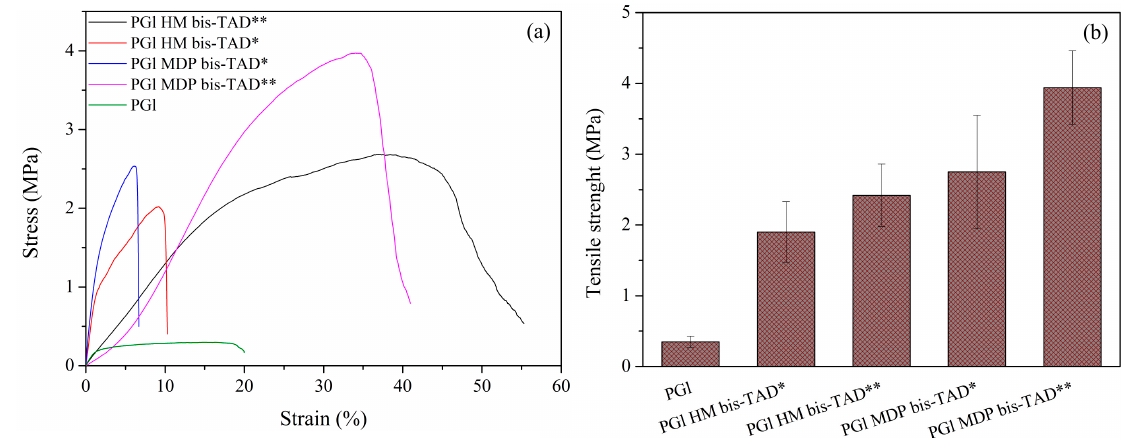
Figure 7. ( a ) Stress strain curves; ( b ) and tensile strength of PGl, PGl HM – bisTAD* (first incubation), PGl HM – bisTAD** (second incubation), PGl MDP – bisTAD* (first incubation) and PGl MDP – bisTAD (second incubation) fibres.